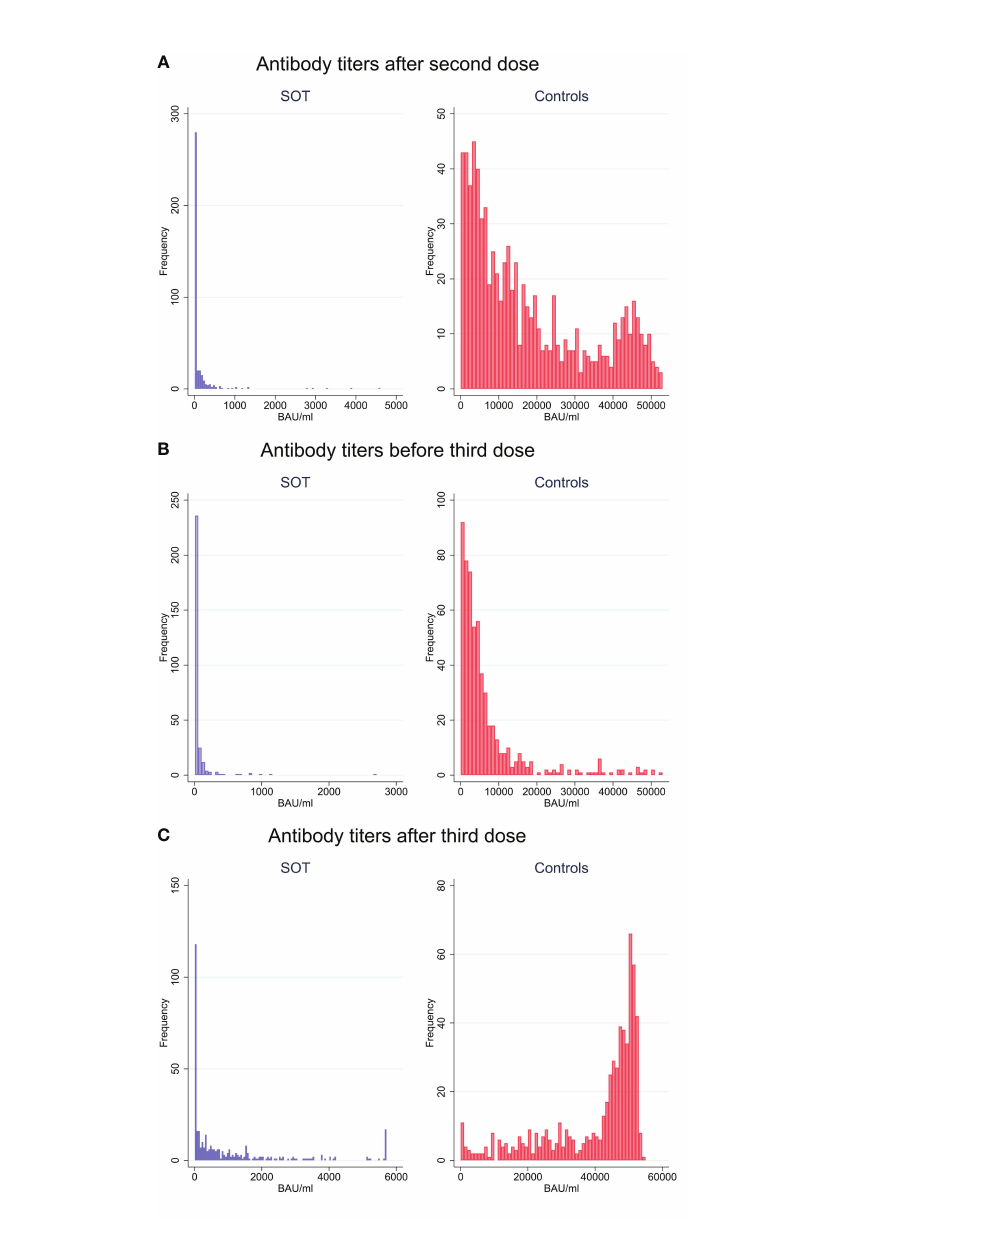
FIGURE 2 Anti-SARS-CoV-2 antibody concentrations to SARS-CoV-2 vaccine in solid organ transplant recipients and matched controls by frequency after second vaccine dose (A) , before third dose (B) and after third dose (C)